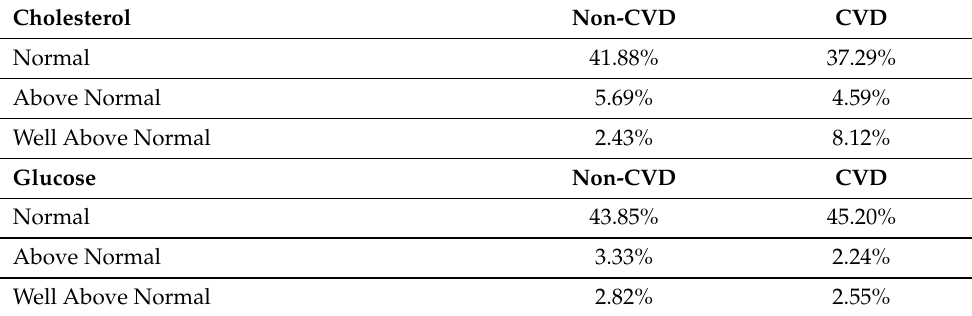
Table 6. Participants’ distribution per cholesterol and glucose level in the balanced